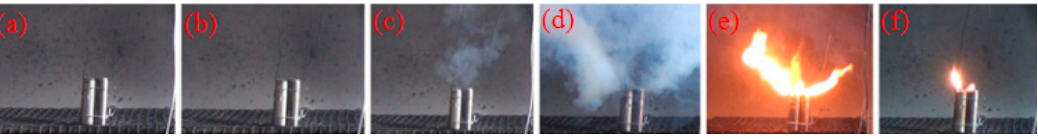
Figure 3. The experimental phenomena during thermal runaway: ( a ) heating stage; ( b ) safety vent opening; ( c ) gases releasing; ( d ) thermal runaway; ( e ) ignition and combustion; ( f ) abatement and extinguishment.